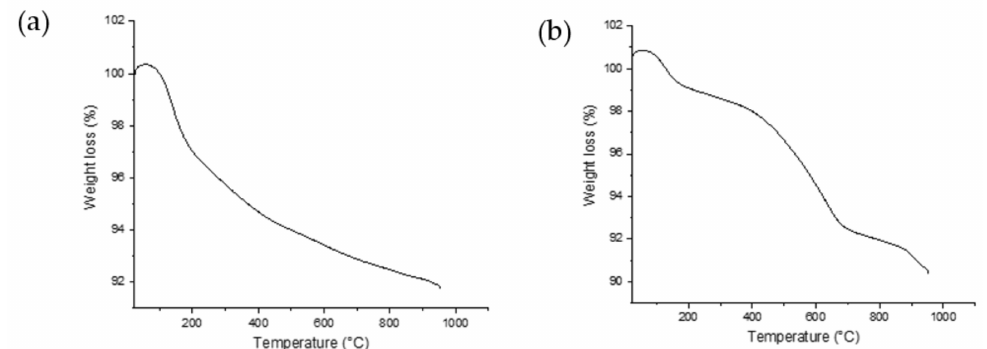
Figure 7. Thermo-gravimetric analysis of fresh ( a ) and used ( b )